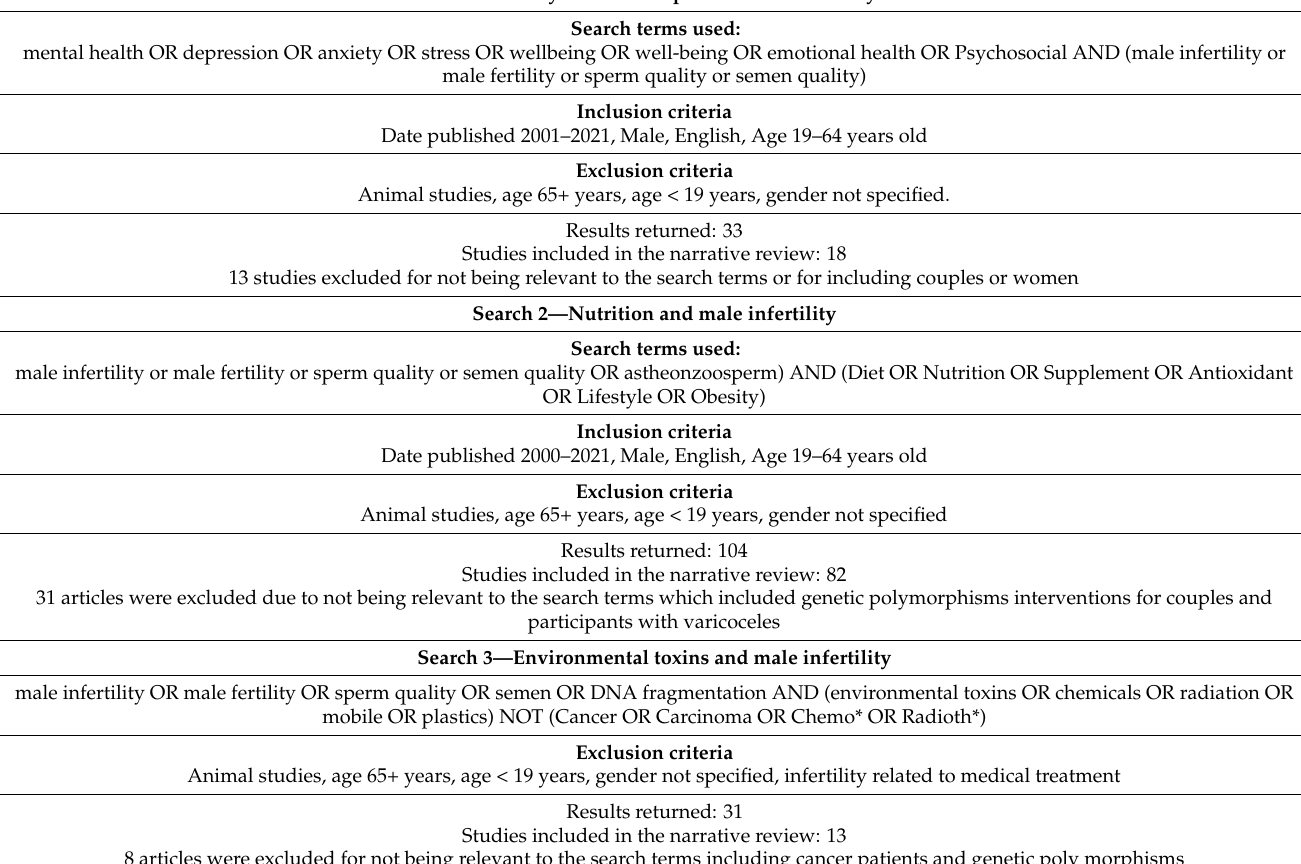
Table 1. Search terms, inclusion/exclusion criteria and search